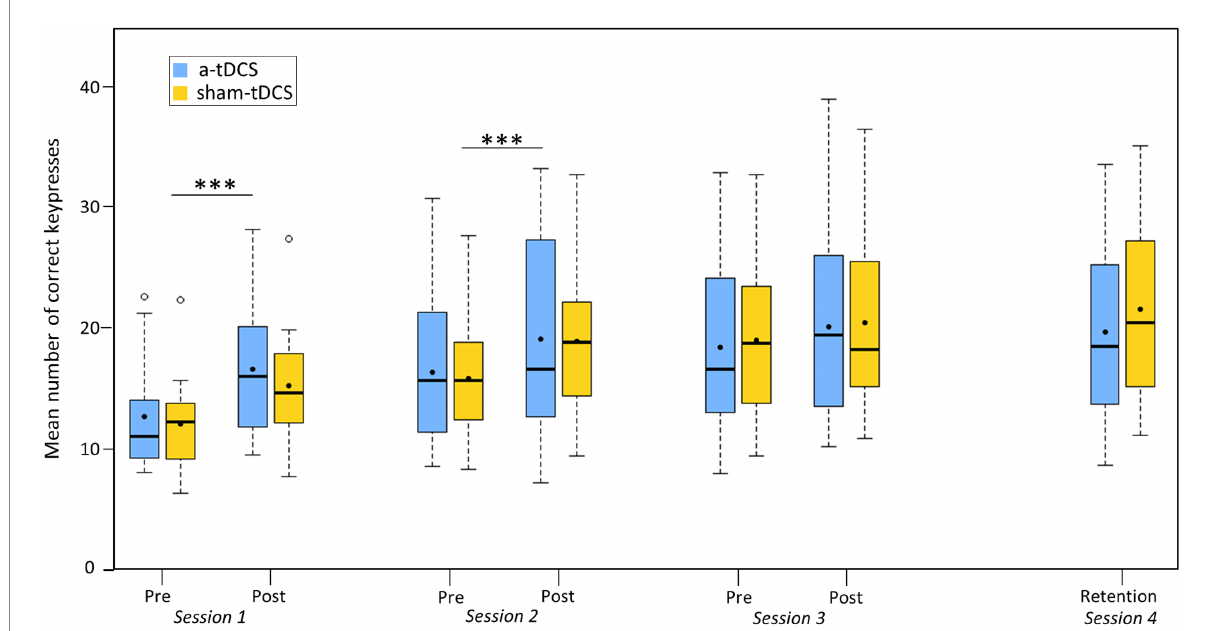
FIGURE 2 Motor performance. Boxplot of the number of correct keypresses during the different tests (pre-tests, post-tests, and retention test) for the four sessions, the sham-tDCS (yellow curve) and the a-tDCS (blue curve) groups. Dots within each boxplot represent the mean. *** = p < 0.001, main effect of